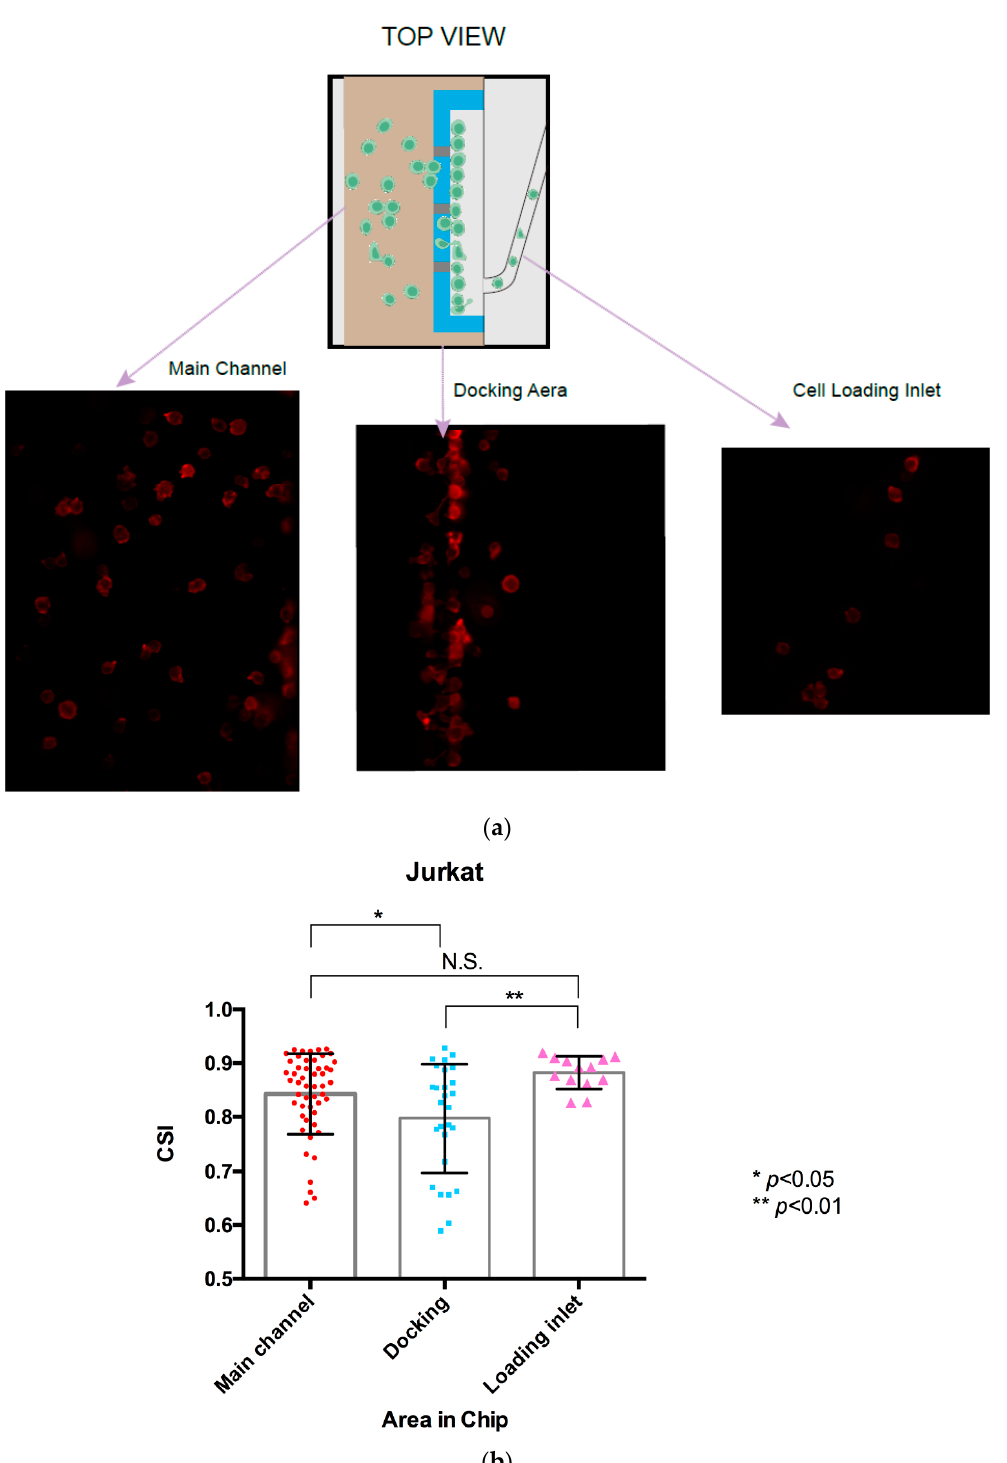
Figure 4. Cells were stained by phalloidin to observe actin filament expansion. ( a , b ) Jurkat cells were fixed at the end of 5 h chemotaxis migration experiments, followed by F-actin staining with Phal- loidin-iFluor 594 reagents working solution. ( a , b ) Representive different cells locations under dif- ferent focal planes. ( c ) Primary T cells were fixed at the end of 0.5 h chemotaxis migration experi- ments, followed by F-actin staining with Phalloidin-iFluor 594 reagents working solution.